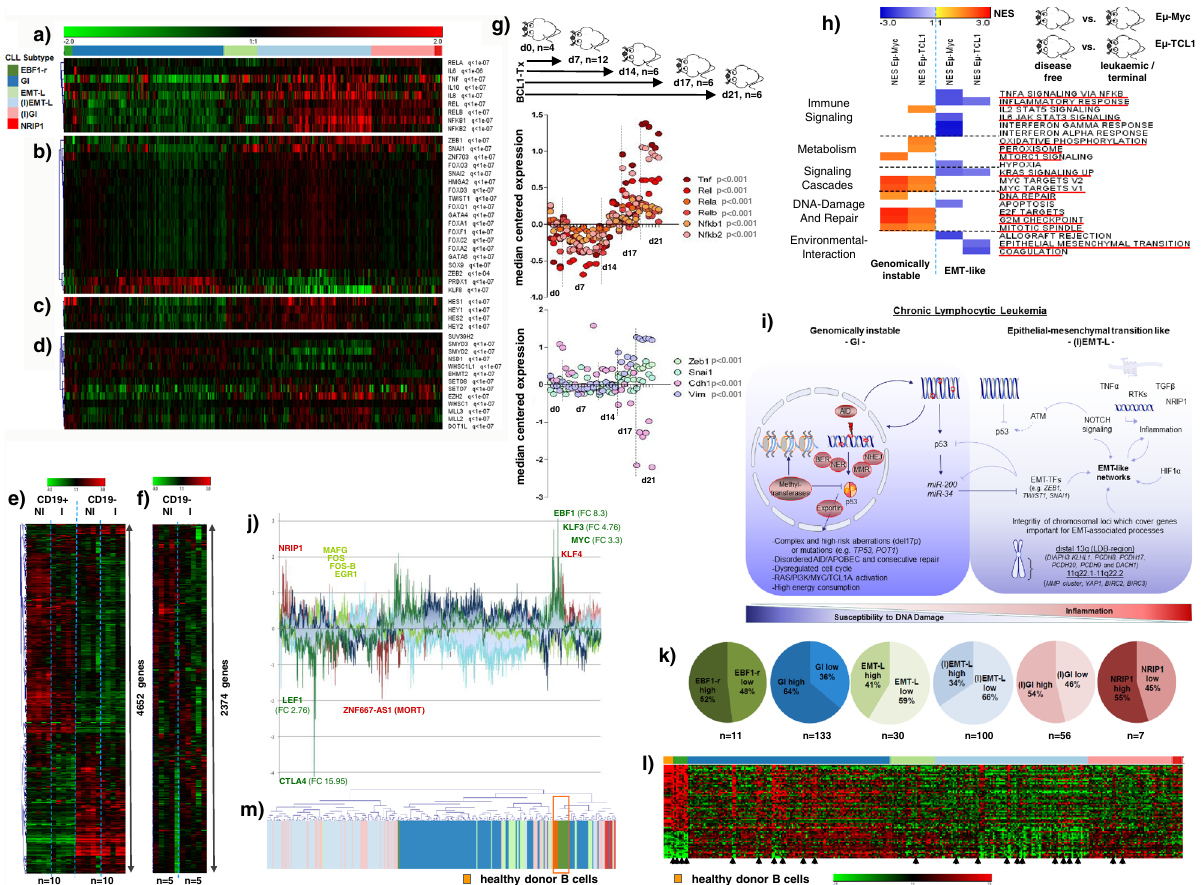
Fig. 4 Biological processes operative in CLL with EMT-like networks. a – d Heatmap showing expression pro fi les ( n = 337) for a genes indicating activated TNF α /NF-kB signaling, b EMT-TFs, c NOTCH target genes (intensity range − 1:1), d histone lysine methyltransferases. FDRs of DEGs (GI vs. (I)EMT-L) are indicated on the right (q). CLL subtype color code de fi ned in Fig. 4a applies for Fig. 4a – d, j – m. e GEP of the CD19 positive ( + ) and negative ( − ) compartment from CLL samples with in fl ammatory (I) and non-in fl ammatory (NI) signatures. f GEP of 2374 variably expressed genes for the CD19 negative fraction. g Tumor GEP indicating activated TNF α /NF-kB signaling and induction of EMT-like programs after BCL 1 tumor transplantation. y -axis: median centered expression, x -axis: days (d) after transplantation of individual samples ( p <0.05 shown for d7 vs. d21, Mann – Whitney (two-sided)). h Heatmap showing gene set enrichment, characteristic for CLL with genomic instability or activation of EMT-like programs, in E µ -Myc and E µ -TCL1 mice. Gene sets were identi fi ed through GSEA (FDR<0.05) on proteome pro fi les of splenic tumor cells from leukemic or terminal E µ -Myc and E µ -TCL1 mice ( n = 4, in two pools) compared with B cells of tumor-free wild-type mice ( n = 12, in two pools). Color-coded normalized enrichment scores (NES) (degree of enrichment; positive: yellow to red; negative: blue, light to dark). Gene sets are grouped according to the biological context. i Model illustrating biologic characteristics and regulatory interplay of processes in major subgroups (GI and (I) EMT-L), as speci fi ed in respective results sections. j Expression pro fi les for 2359 variably expressed genes (SD>0.5). Genes with the highest signi fi cance ( q <1e − 05) for the EMT-L, EBF1-r, and NRIP1 cluster are indicated. Fold change (FC) is indicated for EBF1-r speci fi c genes (EBF1-r vs. all other). k Piecharts illustrating global gene expression, percentages indicating over- or under-expression in relation to the median expression per gene across the dataset. l Heatmap showing genes ( n = 69) with strongest differential expression ( q ≤ 0.05, FC ≥ 2) between the EBF1-r vs. all other clusters. CD19 sorted healthy donor B cells are included (orange). Arrowheads indicate cases with tri(12). m Agglomerative hierarchical clustering (2359 genes, Pearson complete) for n = 337 CLL and n = 5 healthy donor B cells (orange). For Fig. 4a – f, h – m, data within individual fi gures derives from biologically independent